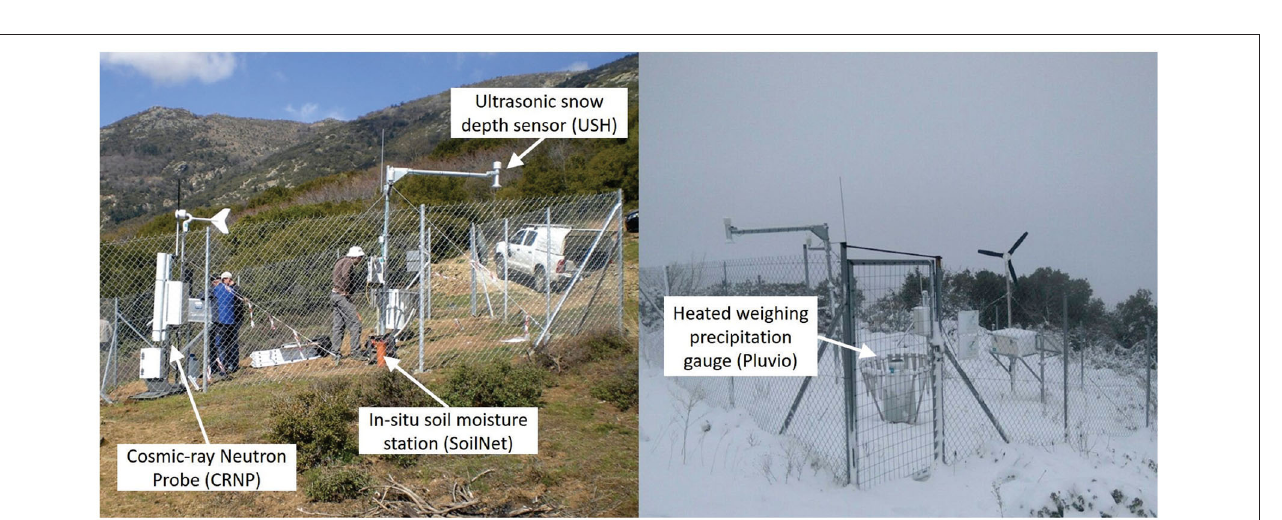
monitor at the Jungfraujoch were used to determine f sol (Zreda et al., 2012). The aim of these correction factors is to normalize the neutron counting rate to a number of reference conditions: the barometric reference pressure, the reference humidity, and